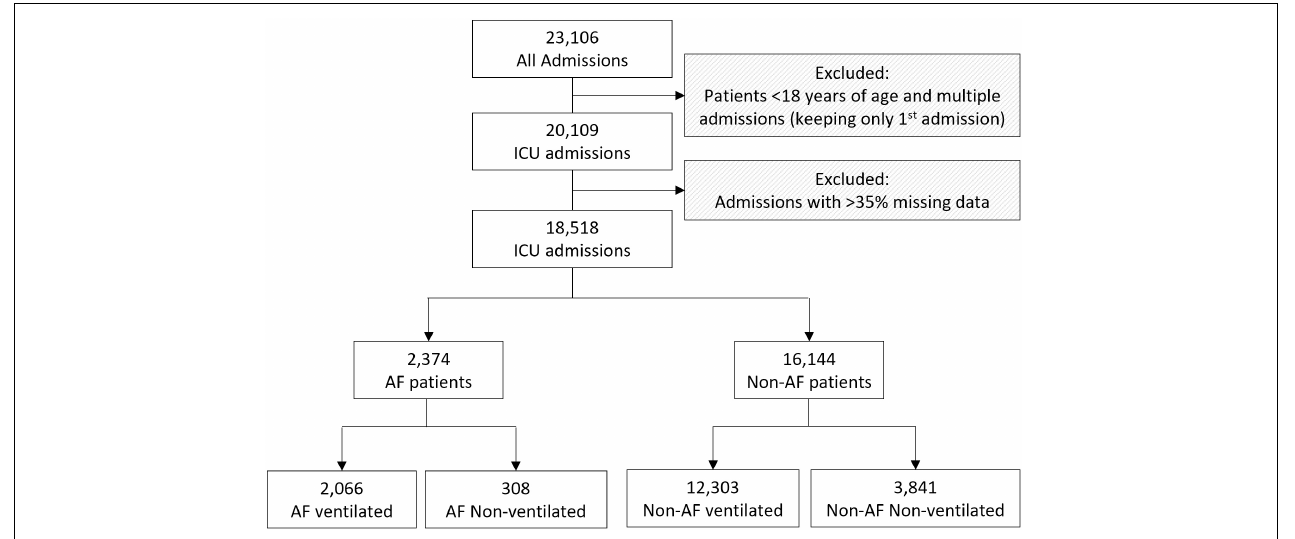
FIGURE 1 | Flowchart of the cohorts analysed including the inclusion and exclusion criteria. ICU: intensive care unit; AF: Atrial Fibrillation.